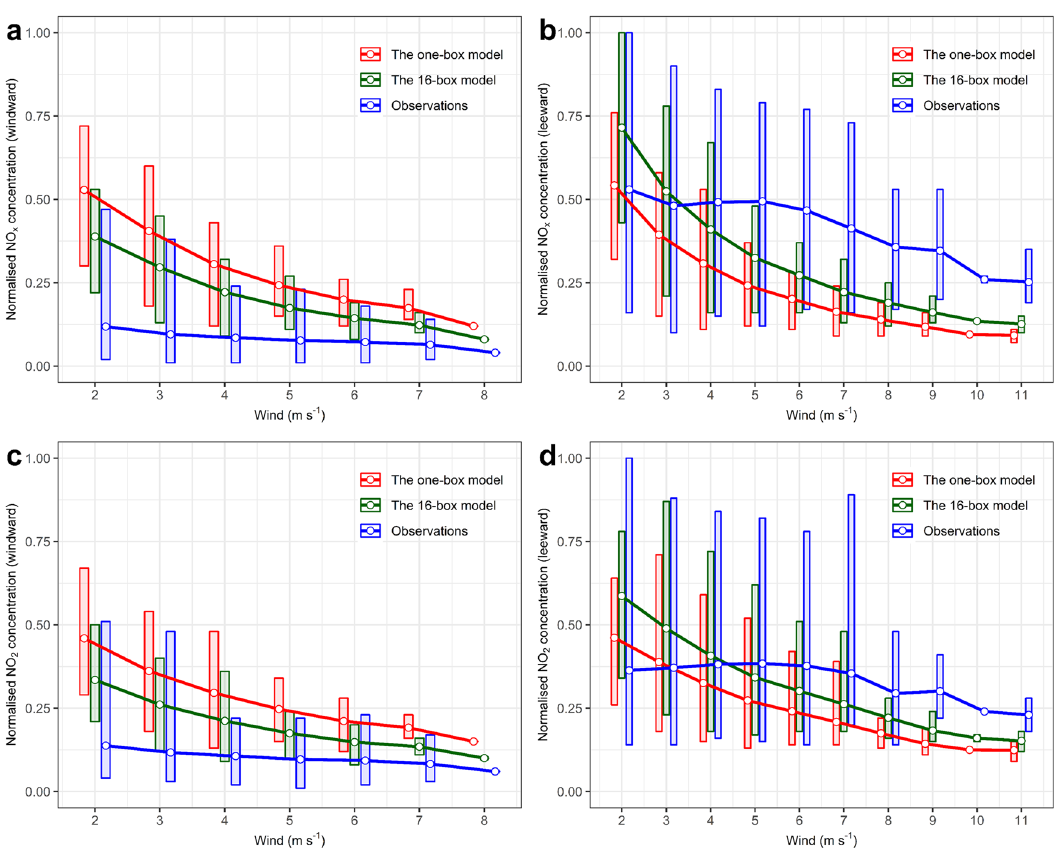
Fig. 6 Comparison of model results against observations. Comparison of normalized modelled NO x and NO 2 concentrations against observations in Marylebone Road at various prevailing wind velocities ( U 0 ) for the windward ( a , c ) and leeward ( b , d ) conditions. The error bars represent the range of data at the same U 0 , and thus a similar air fl ow pattern within the street canyon. The points represent the average values for each